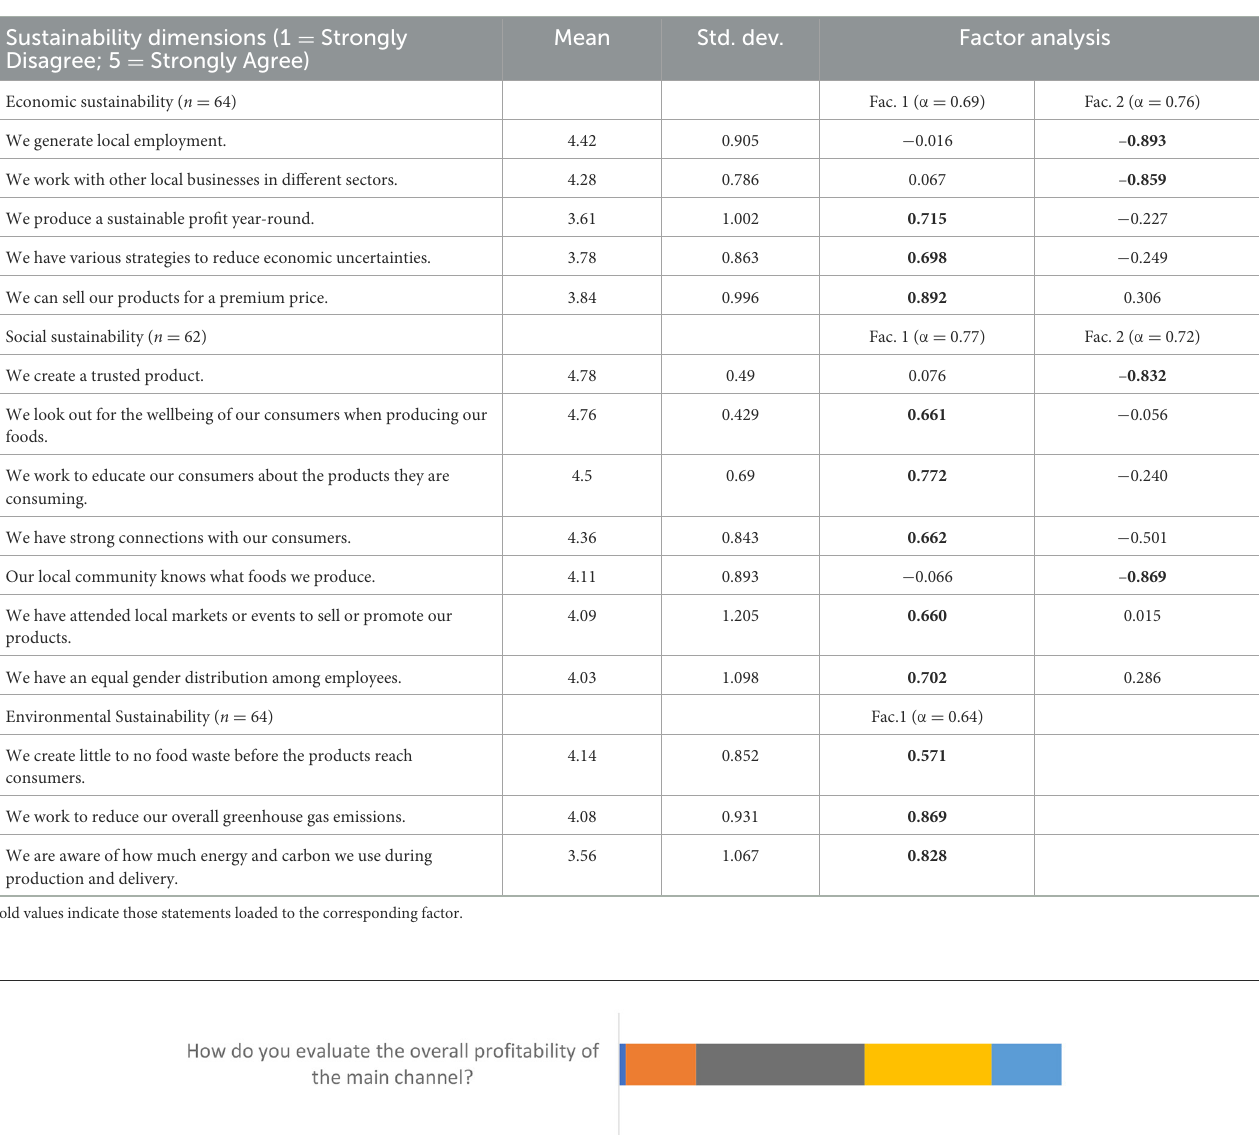
TABLE 4 Sustainability of SFSCs (farm businesses’ perspectives).